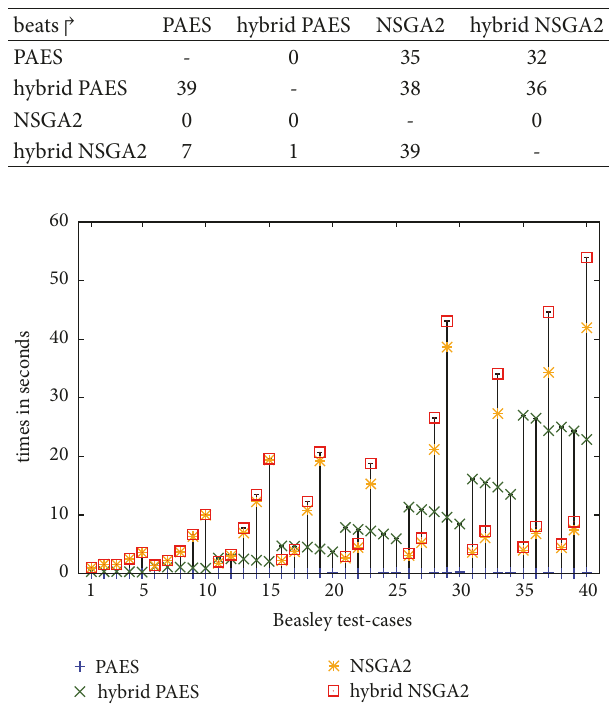
Figure 3: Compared mean execution times (30 runs) for different algorithms on the Beasley benchmark. Exact algorithms execution times, not presented, range from